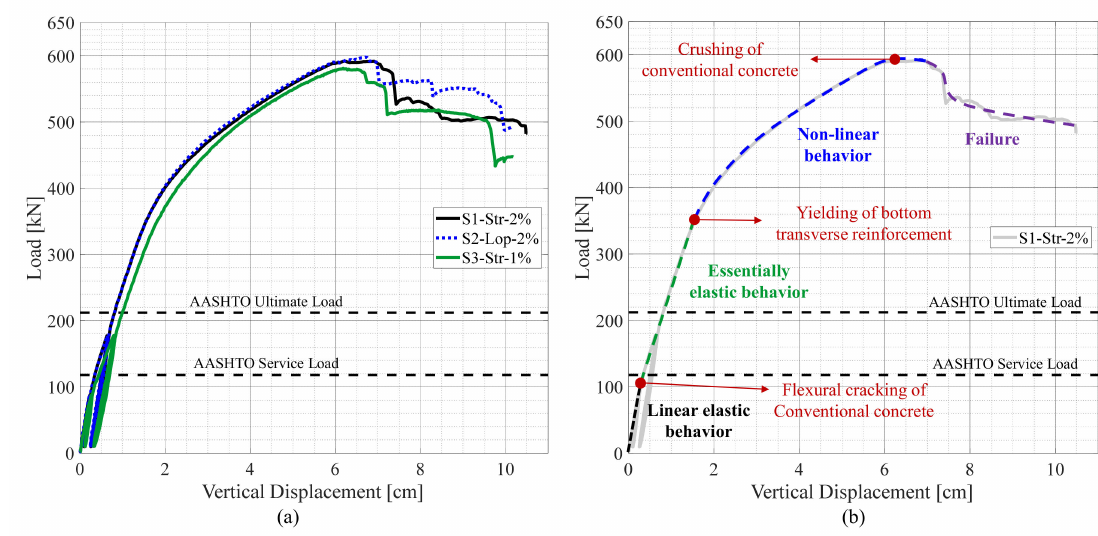
Figure 8. Global Behavior of the NP-UHPC specimens: ( a ) Load versus mid-span deflection relationships of the tested specimens; ( b ) Stages of the flexural behavior of specimen